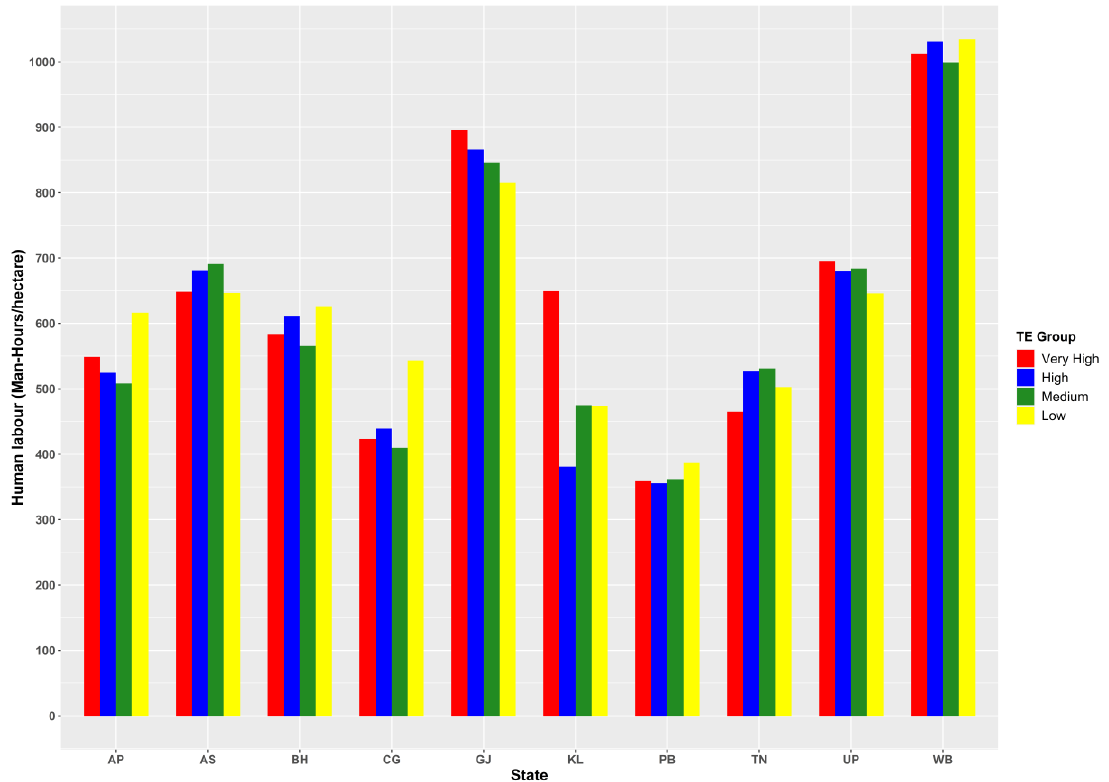
Figure 5. Human labor use in paddy (man-hours/hectare) across various states and efficiency